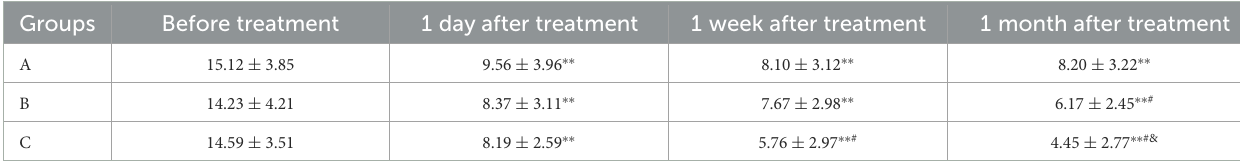
TABLE 3 PSQI scores of patients before and after treatment (mean ± SD). Groups